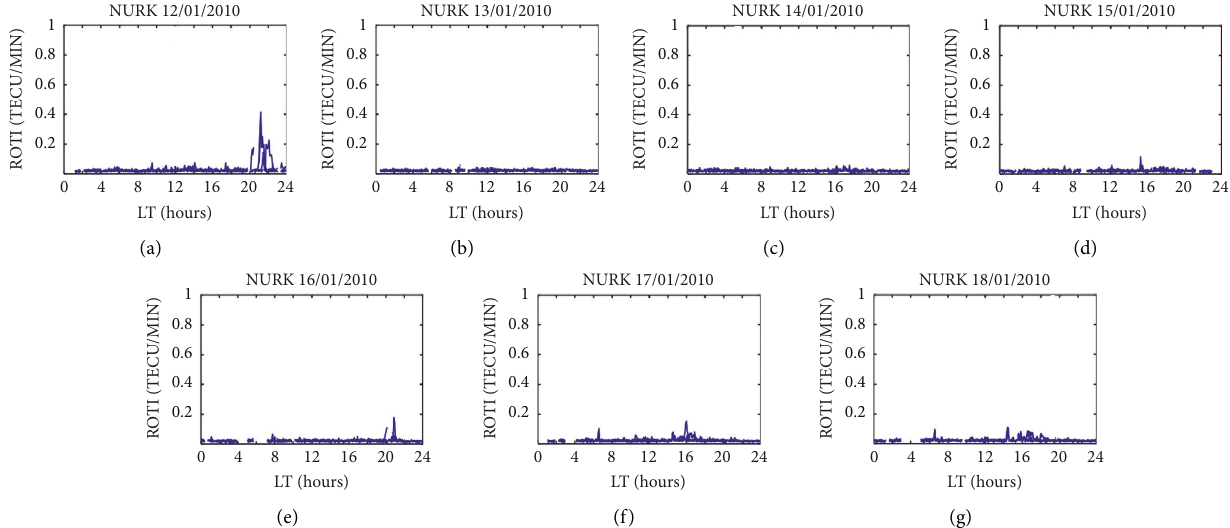
Figure 17: ROTI against LTover NURK station for (a) 12 th January 2010, (b) 13 th January 2010, (c) 14 th January 2010, (d) 15 th January